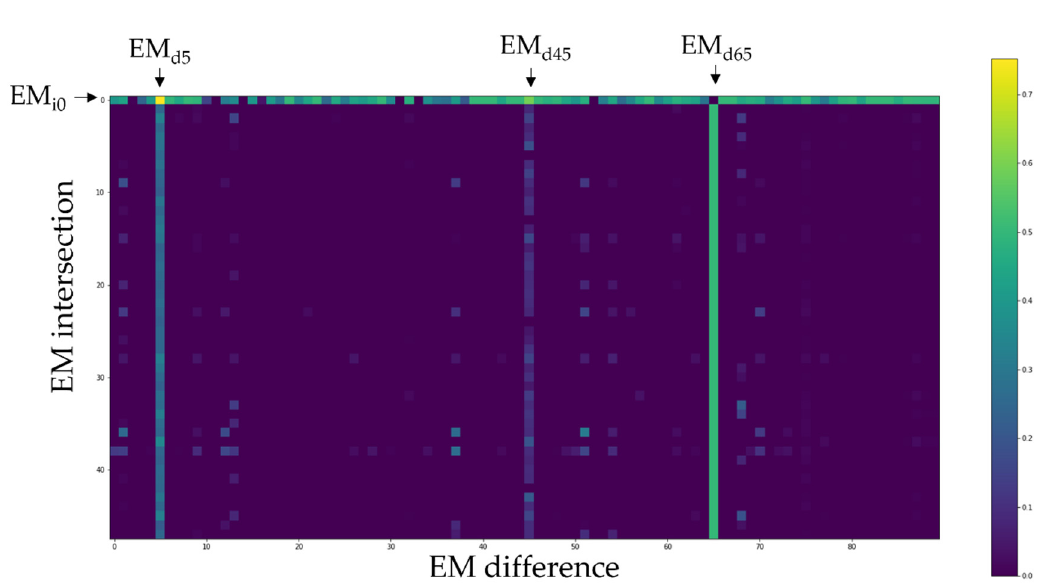
Figure 4. The clustering principle of intersections (green) and differences (blue) for two datasets, X 1 and X 2 .